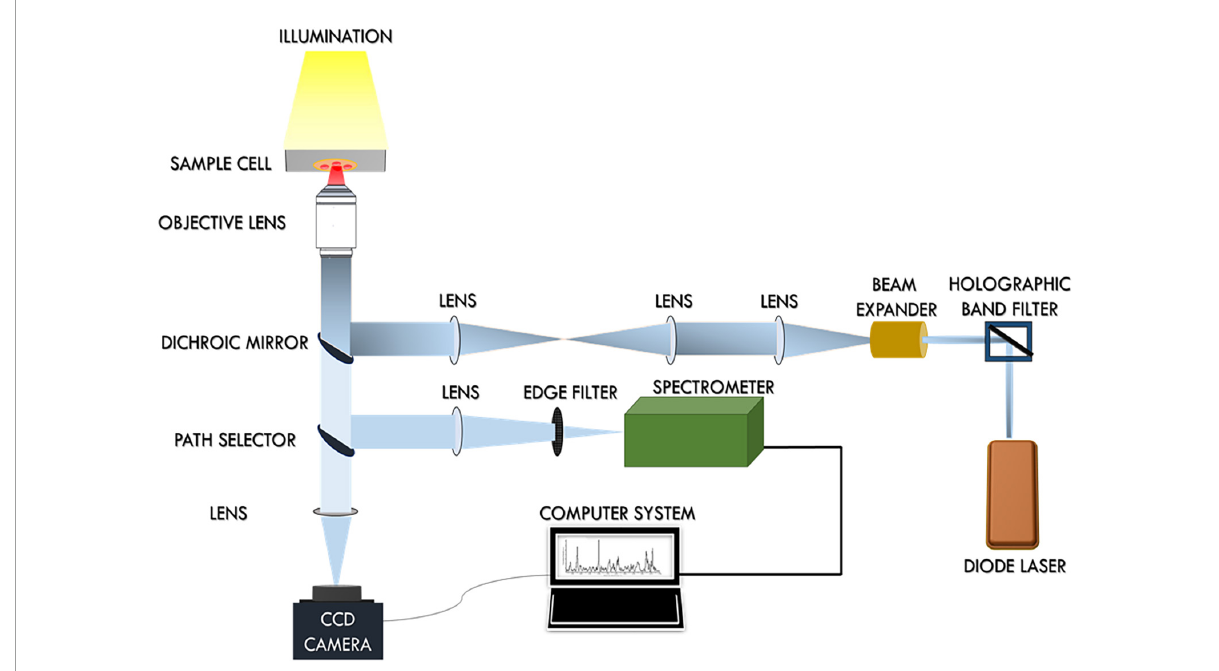
FIGURE1 Schematic diagram of the Raman Tweezers set